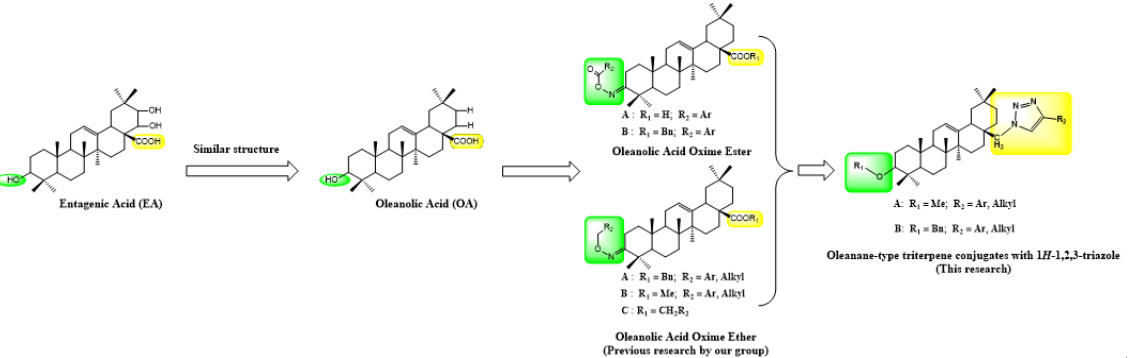
Figure 1. The structural formula of Entagenic Acid, Oleanolic Acid, oleanolic acid oxime es- ter/oleanolic acid oxime ether and Oleanane-type triterpene conjugates with 1 H